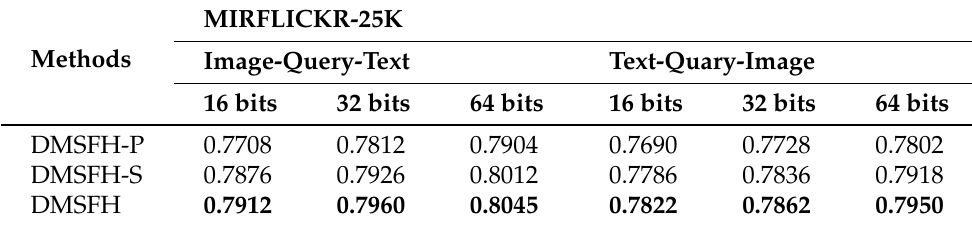
Table 6. Ablation experiments of DMSFH on the MIRFLICKR-25K dataset. The best results are in bold